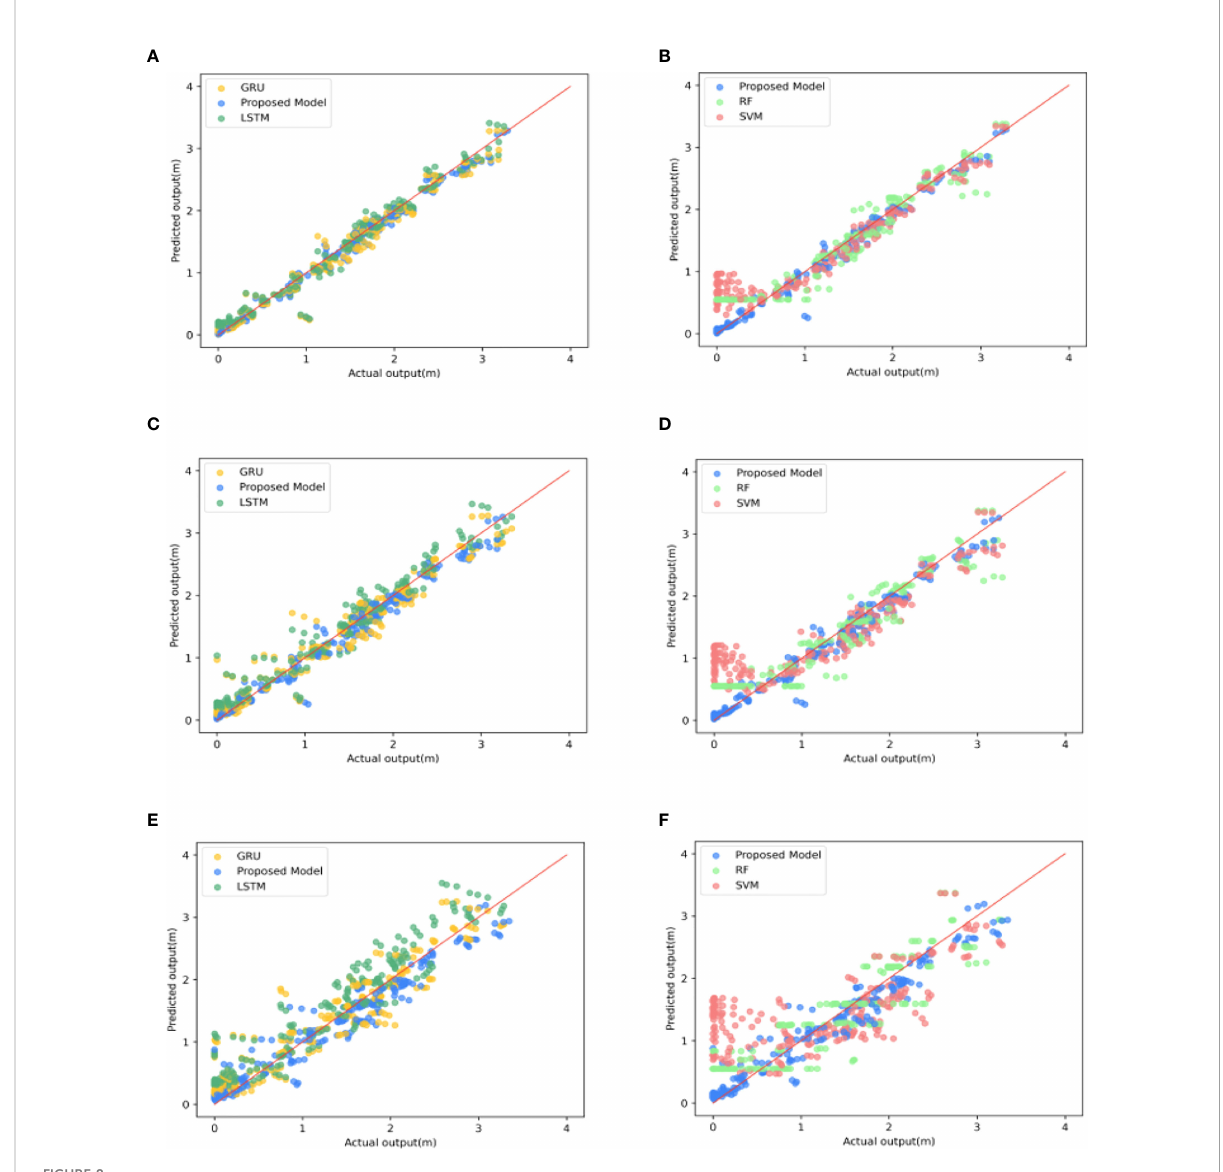
FIGURE 8 Scatter plots of fi ve groups of algorithms in different forecast times: (A, B) 1 h, (C, D) 3 h, (E, F) 6